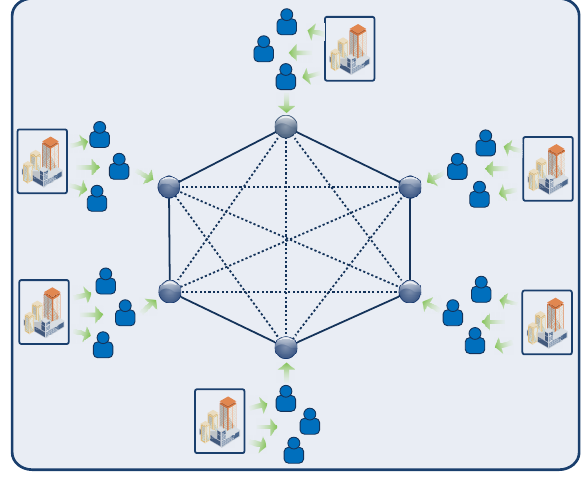
Figure 7. Consortium blockchain [79].